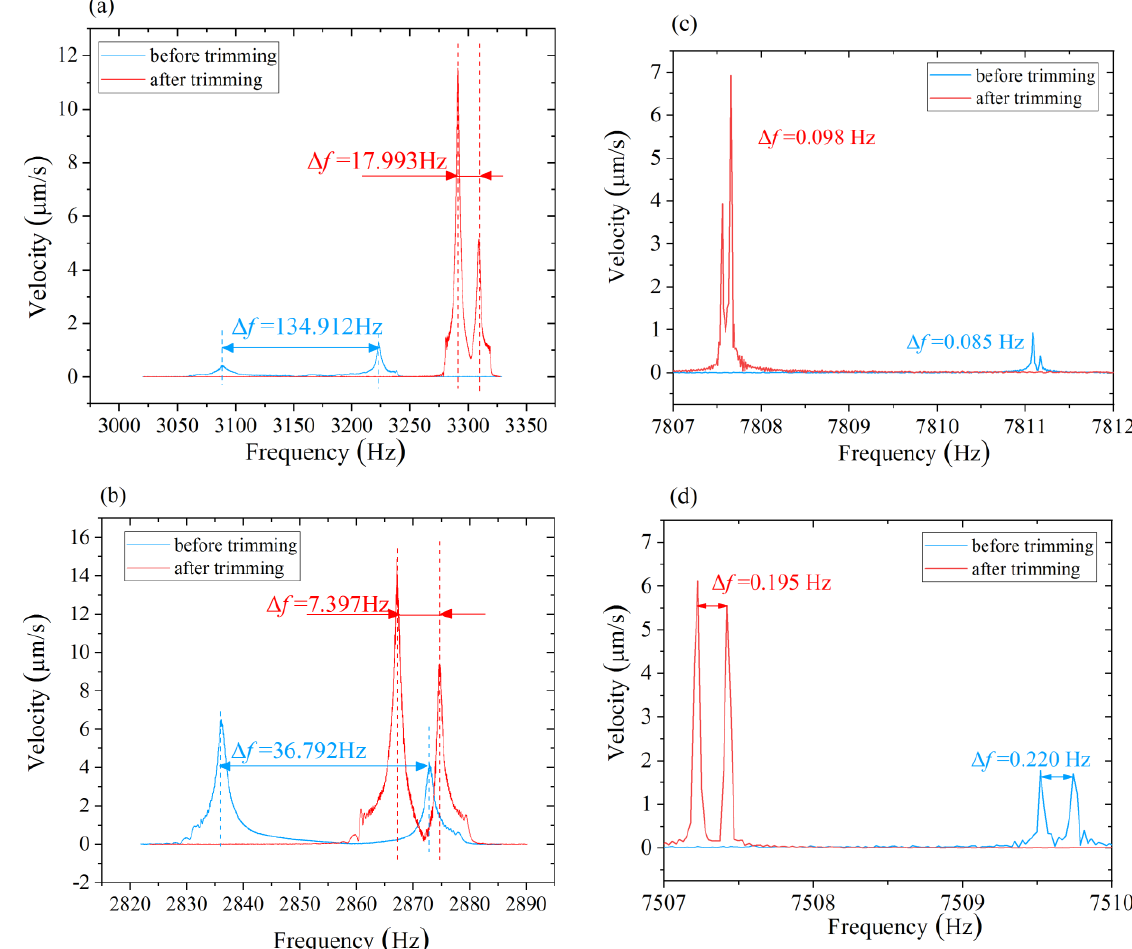
Figure 13. Variations of frequency split before and after chemical balancing: ( a ) n = 1 mode of Resonator R01; ( b ) n = 1 mode of Resonator R02; ( c ) n = 2 mode of Resonator R01; ( d ) n = 2 mode of Resonator R02.